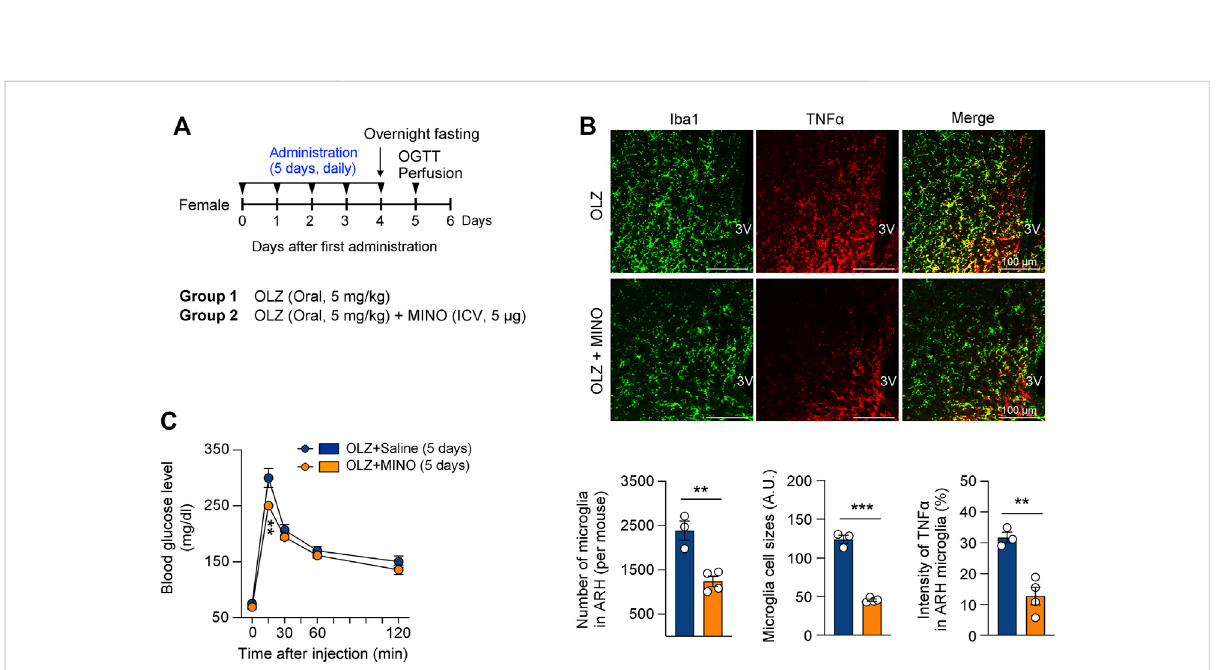
FIGURE 4 Minocycline (MINO) ameliorates olanzapine (OLZ)-induced glucose intolerance by decreasing microglial activation in female mice. (A) Experimental scheme pertaining to mice that were administered OLZ or OLZ + MINO on postnatal week 7. (B) The numbers and sizes of Iba1- expressing microglia and the expression of microglial TNF α in the ARH of female mice that were administered OLZ or OLZ + MINO for 5 days ( n = 3 – 4). (C) Glucose tolerance tests were performed after the administration of OLZ or OLZ + MINO for 5 days ( n = 4). Data are presented as mean ± SEM values. Statistical analyses were performed using two-sided Student ’ s t- test (B) and one-sided two-way analysis of variance (ANOVA) (C) followed by a post hoc least signi fi cant difference (LSD) test. ** p < 0.01 and *** p < 0.001 between the indicated groups. Scale bars: 100 μ